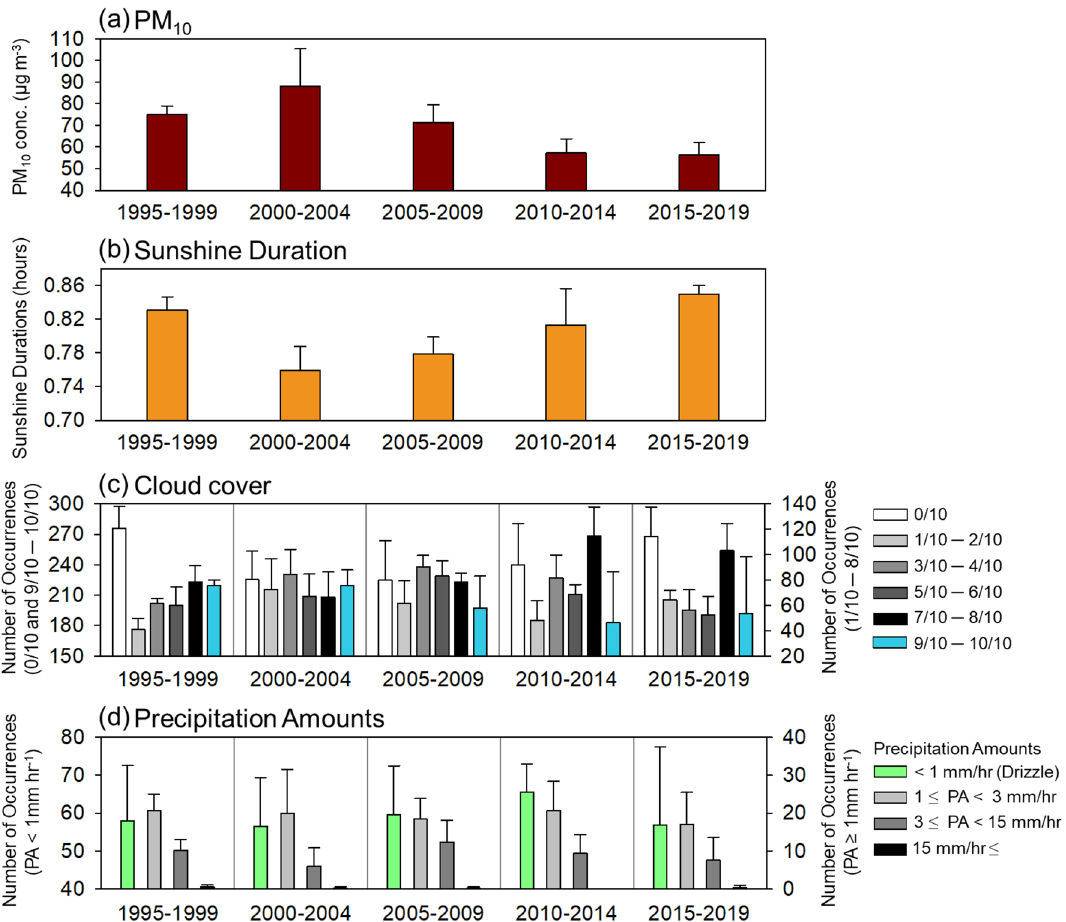
Figure 3. Long-term (1995–2019) springtime trends for ( a ) PM 10 concentration, ( b ) sunshine duration, ( c ) the frequency of cloud cover for each cloud cover interval, and ( d ) the occurrences of precipitation intensities divided by hourly precipitation amounts in Seoul, South